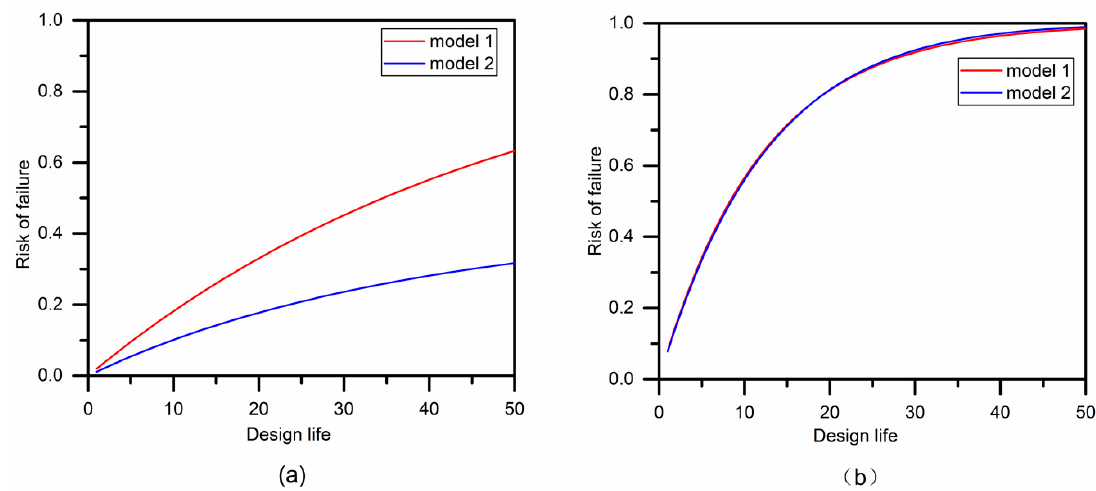
Figure 6. Bivariate risk of failure as a function of design life for ( a ) case AND and ( b ) case OR.